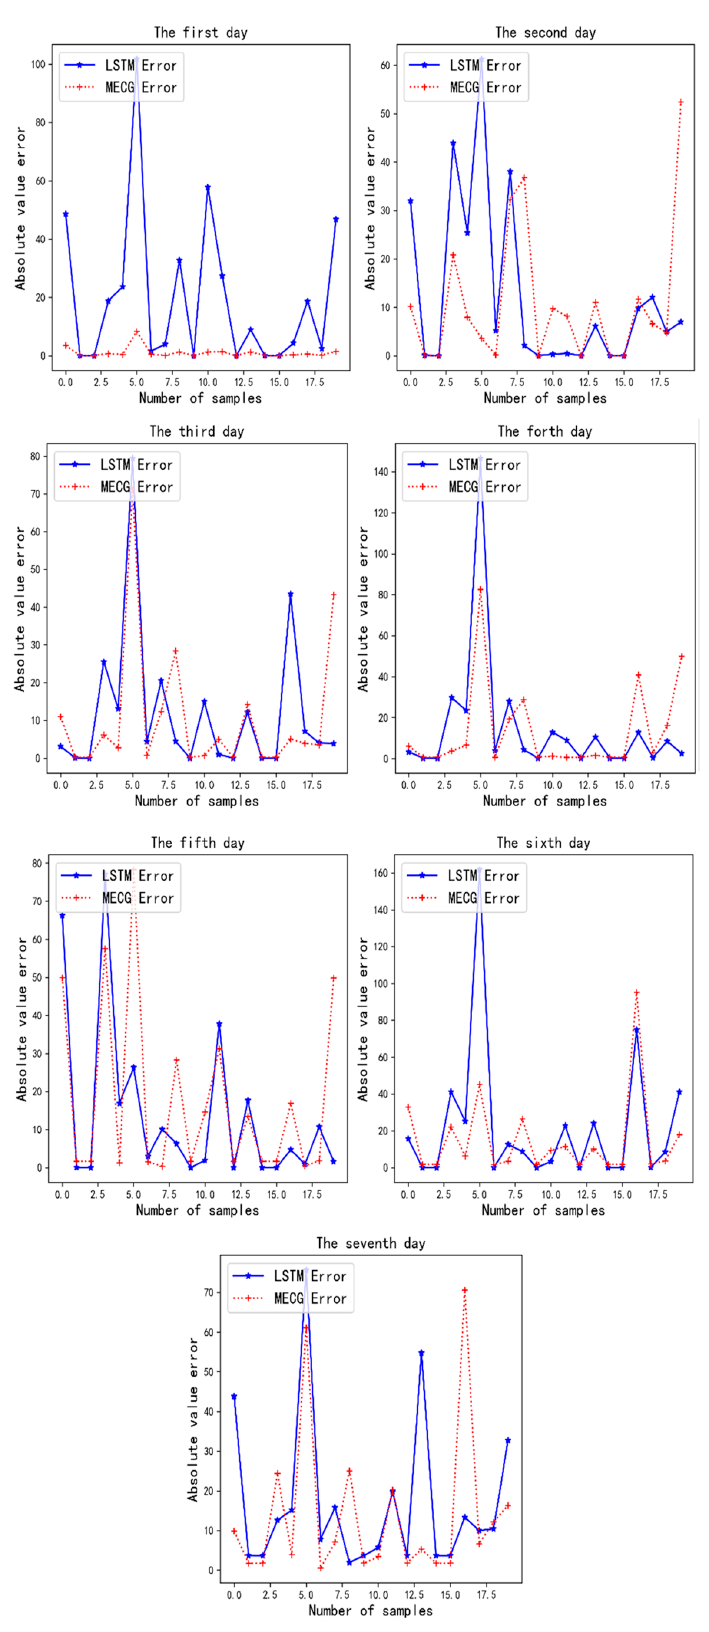
Figure 17. Absolute error values of 20 samples randomly selected by LSTM and MECG.